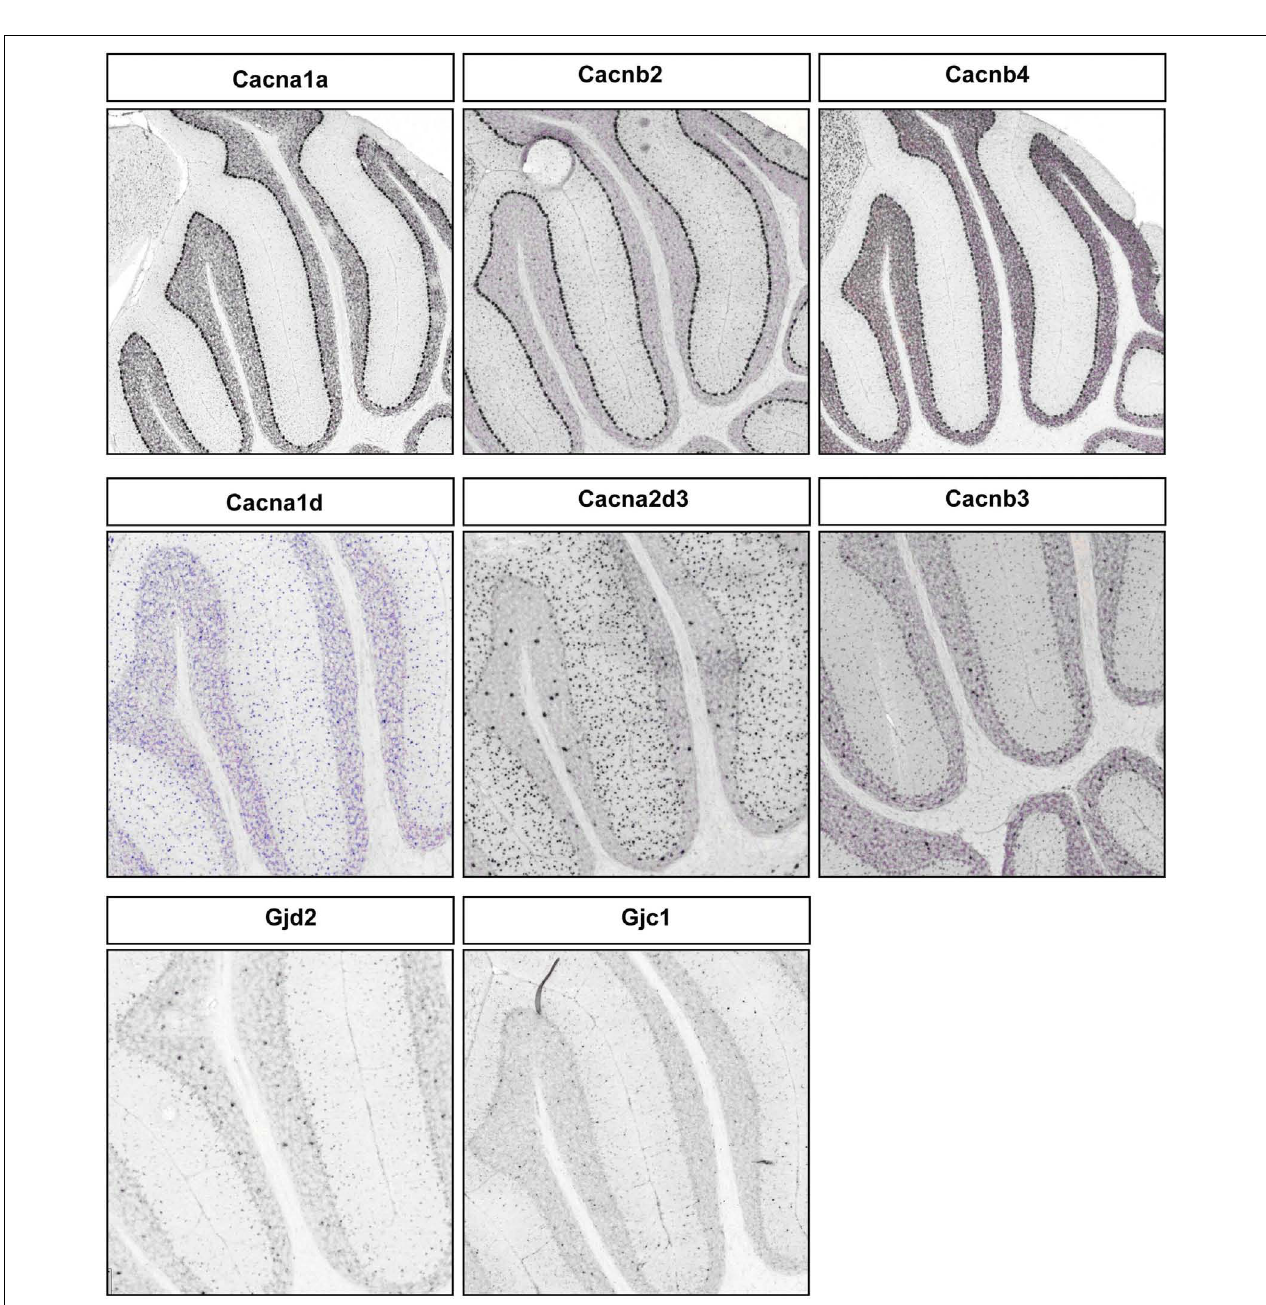
Cacnb2 , and Cacnb4 ; S/BC specific expression of Cacna1d , Cacna2d3 , and Cacnb3 . Also showing the expression of gap junction proteins Gjd2 and Gjc1 in